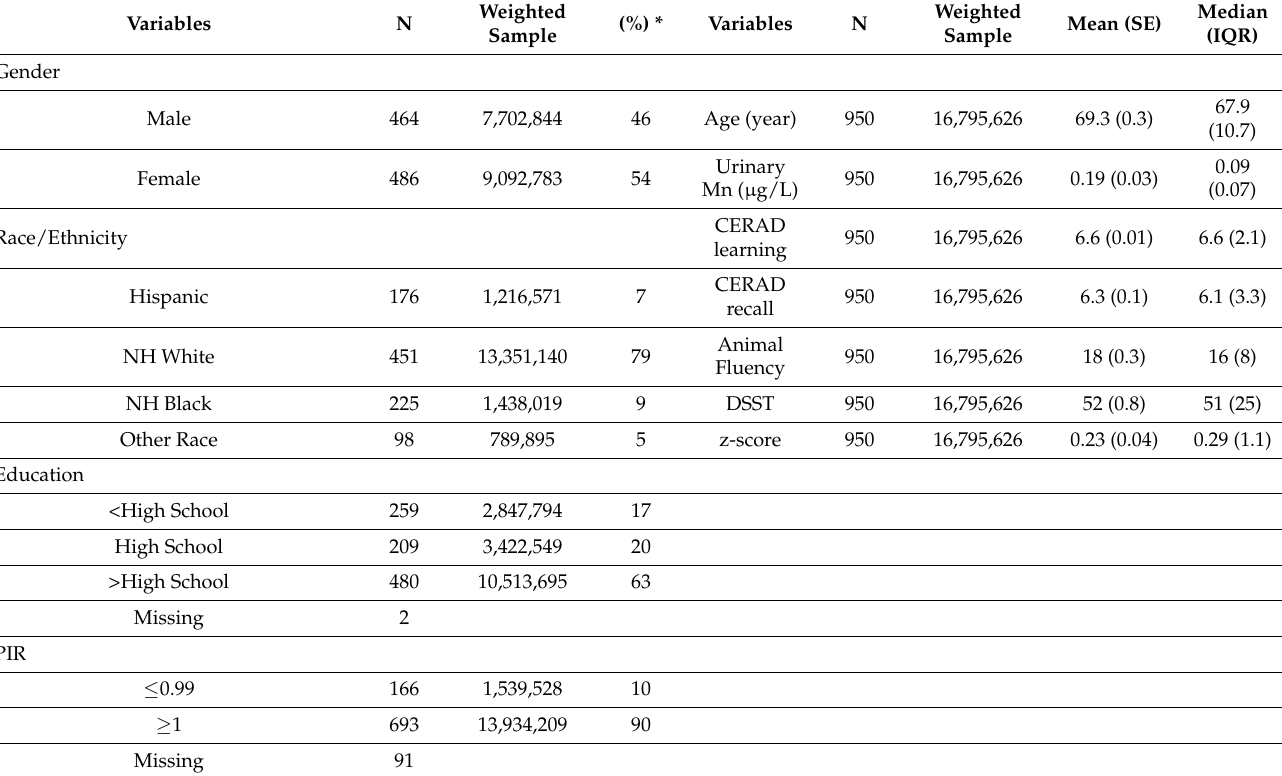
Table 4. Characteristics of the Mn-Urine study population ( n =